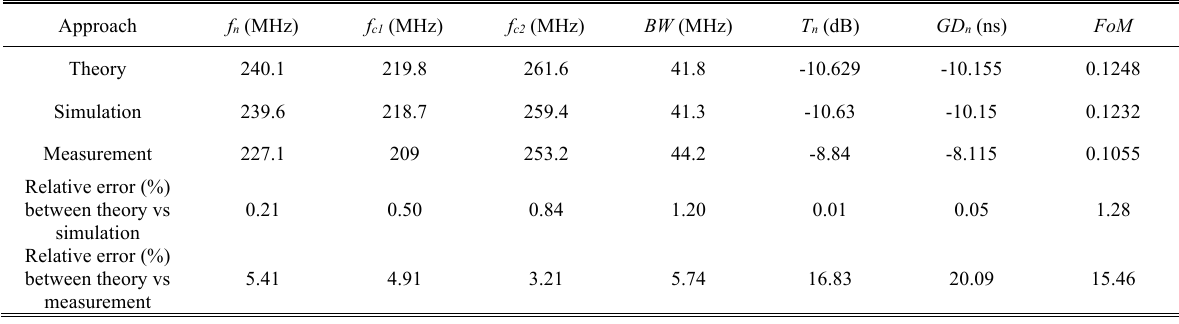
TABLE III. Comparison between the calculated and simulated NGD parameters